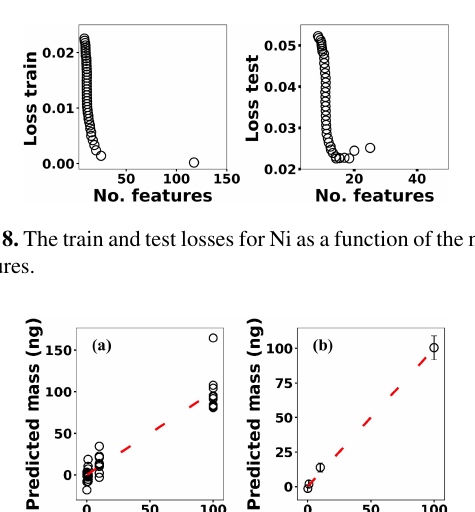
Figure 9. (a) LASSO predictions based on leave-one-out cross val- idation for Ni; (b) the averaged predictions for each concentration.